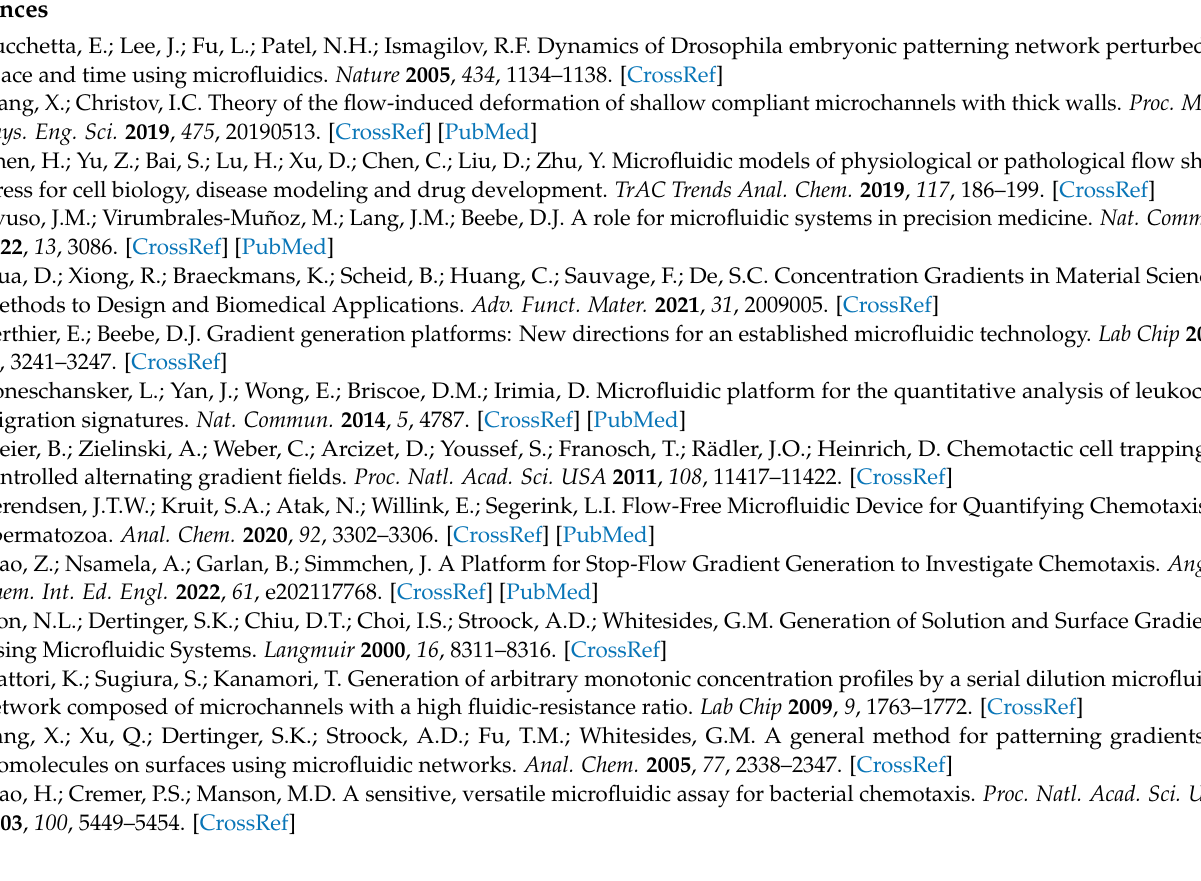
Figure S2: the 3D models in the numerical study; Figure S3: the schematic of the microfluidic chip for flow resistance measurement; Figure S4: simulation results of the deflection of membranes with distinct valve widths; Table S1: details for four-branch design; Table S2: the parameters in simulation models; Table S3: the gas pressures required for different concentration profiles; Table S4: the flow resistance of microvalves for different concentration profiles;